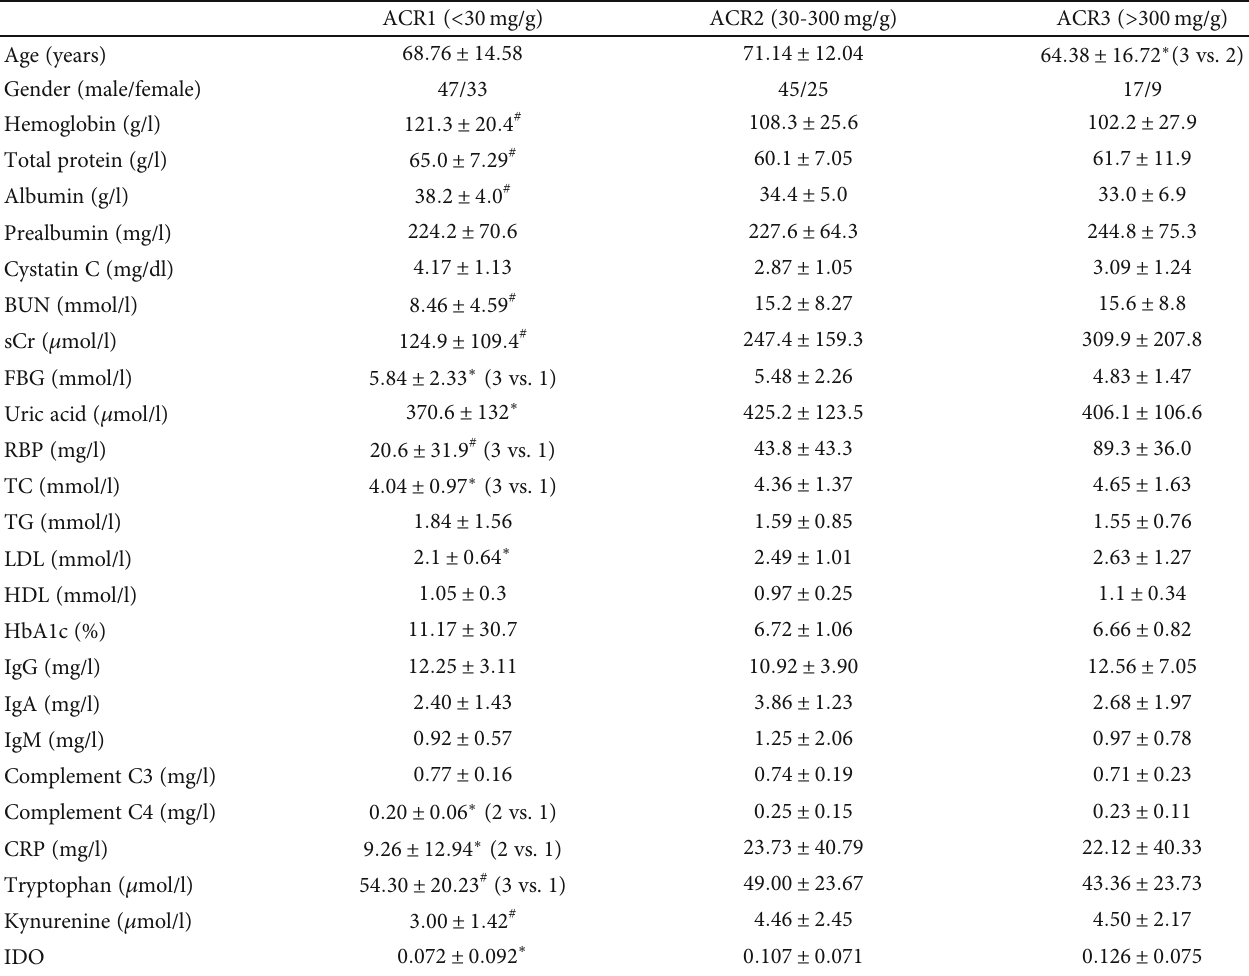
Table 4: Comparison of clinical indices among di ff erent ACR groups.